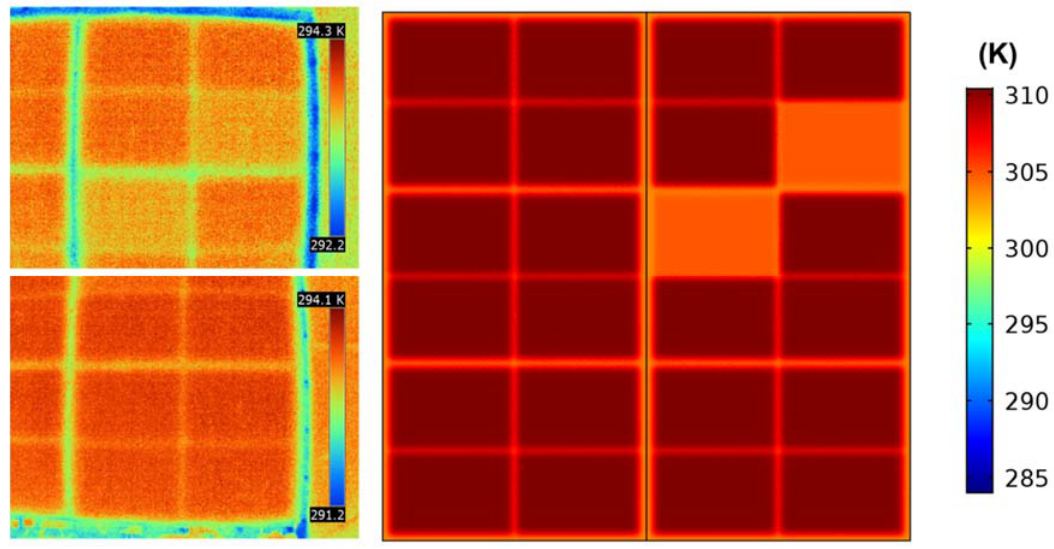
Figure 12. Temperature maps of composite ‘B’ using infrared imaging ( left ) and simulations ( right ), comparing heat flows through intact and failed VIPs.